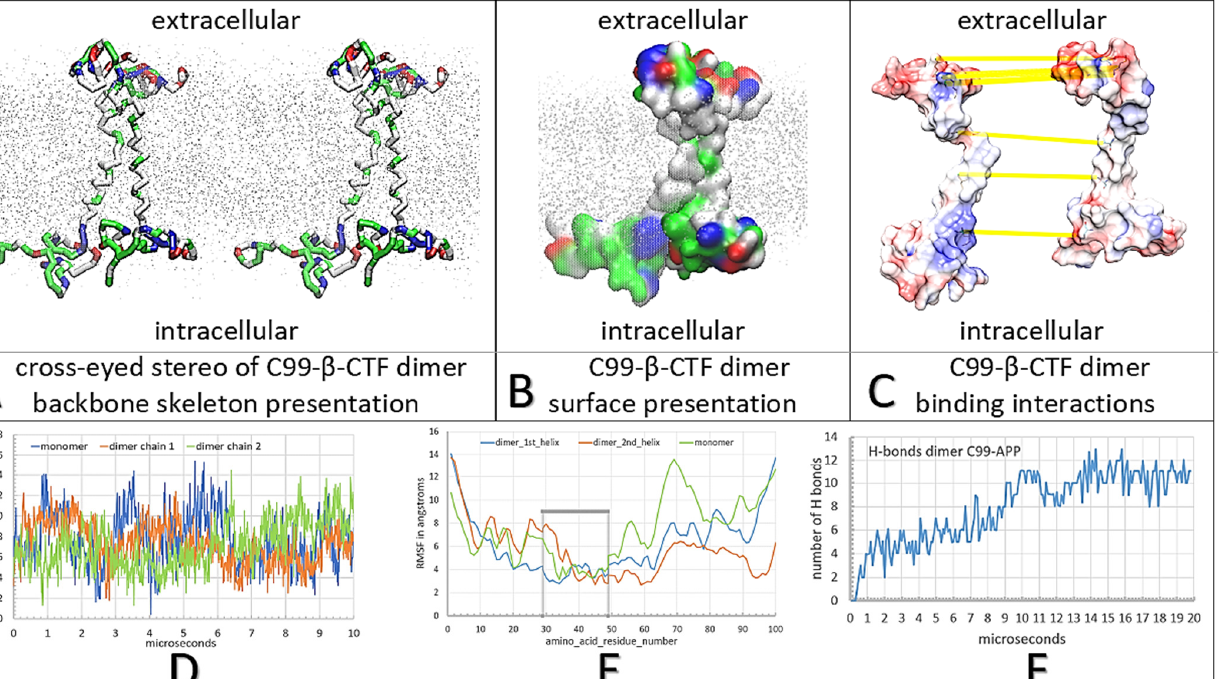
Figure 1. ( A,B ) Multiscale molecular dynamics studies of C99- β -CTF-APP’s structure in a choles- terol–lipid bilayer: Multiscale MD calculations can provide dynamic structural depictions of C99- β -CTF-APP’s structure that can be related to previous studies [27,33,37,41,42] . The amino acids are shown as hydrophobic (white), positive (blue), negative (red), and polar non-charged (green). The cholesterol–lipid bilayer shows surface models of cholesterol (orange) in a mixture of POPC, POPA, POPE, POPS, POPI, and PSM molecules (cyan) (Methods). ( A ) The transmembrane section of the C99- β -CTF-APP backbone can exist in compact and extended forms [27] . The transmembrane helix is hydrophobic (white), with notable polar sites at Thr 43 and Thr 48 (green) and hinge sites at Gly38–Gly39 (green). Changes in Lys29–Lys54 distances (numeration as in PDB:2LP1) show that the shortest conformer is around 33.94 Å long, while the longest conformer is about 44.06 Å long. About 62% of the time, the protein takes conformations that are about 37.7 ± 2.5 Å long. The extracellular and intracellular parts are rich in positive (blue), negative (red), and polar (green) amino acids. The extracellular and intracellular structures represent a dynamic network of competing interaction between different amino acids and polar lipid heads (Supplementary Figure S1). ( B ) C99- β -CTF-APP’s Connolly surface shows that charged and polar amino acids in the extracellular and intracellular domains form compact structures atop the lipid bilayer [27]. The surface of the hydrophobic transmembrane section can be covered (rigidified?) with cholesterol molecules (black lines) [33].